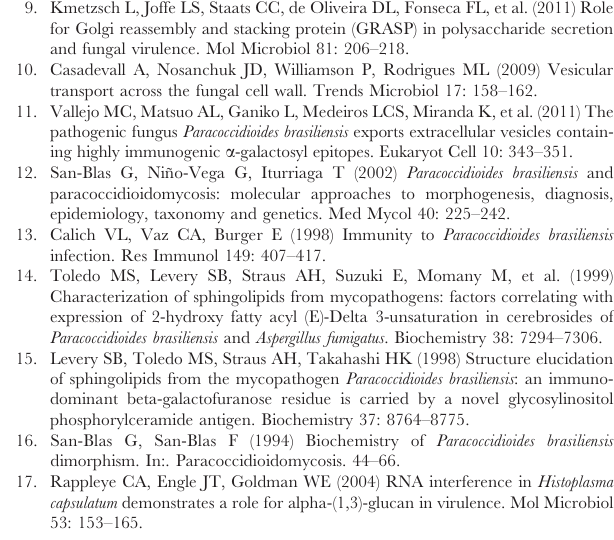
Figure S1 Tandem-MS spectrum of a major phosphati- dylcholine (PC) species (C18:2/C18:1-PC). Samples were dissolved in methanol, containing 10 mM LiOH, and analyzed by ESI-MS/MS in the positive-ion mode. Fragmentation was carried Figure S2 Tandem-MS spectrum of a major phosphati- dylethanolamine (PE) species (C18:2/C18:2-PE). Samples were dissolved in methanol, containing 0.05% formic acid (FA), and 0.05% NH 4 OH, and analyzed by ESI-MS/MS in the Figure S3 Tandem-MS spectrum of a major phosphati- dylcholine (PC) species (C16:0/C18:2-PC). Samples were dissolved in methanol, containing 0.05% FA and 0.05% NH 4 OH,